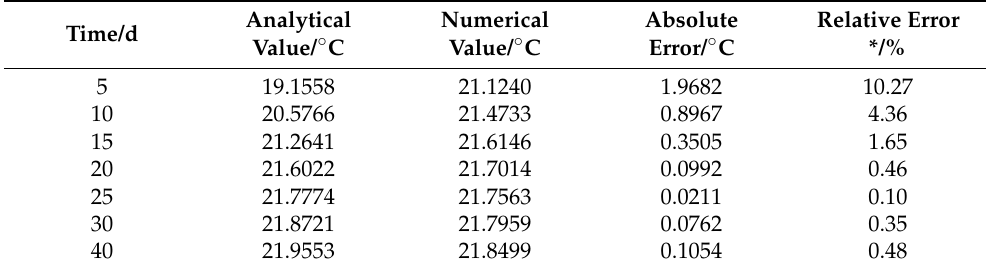
Table 3. Comparison of analytical and numerical results of virtual observation point 2 ( x = 1.0 m).